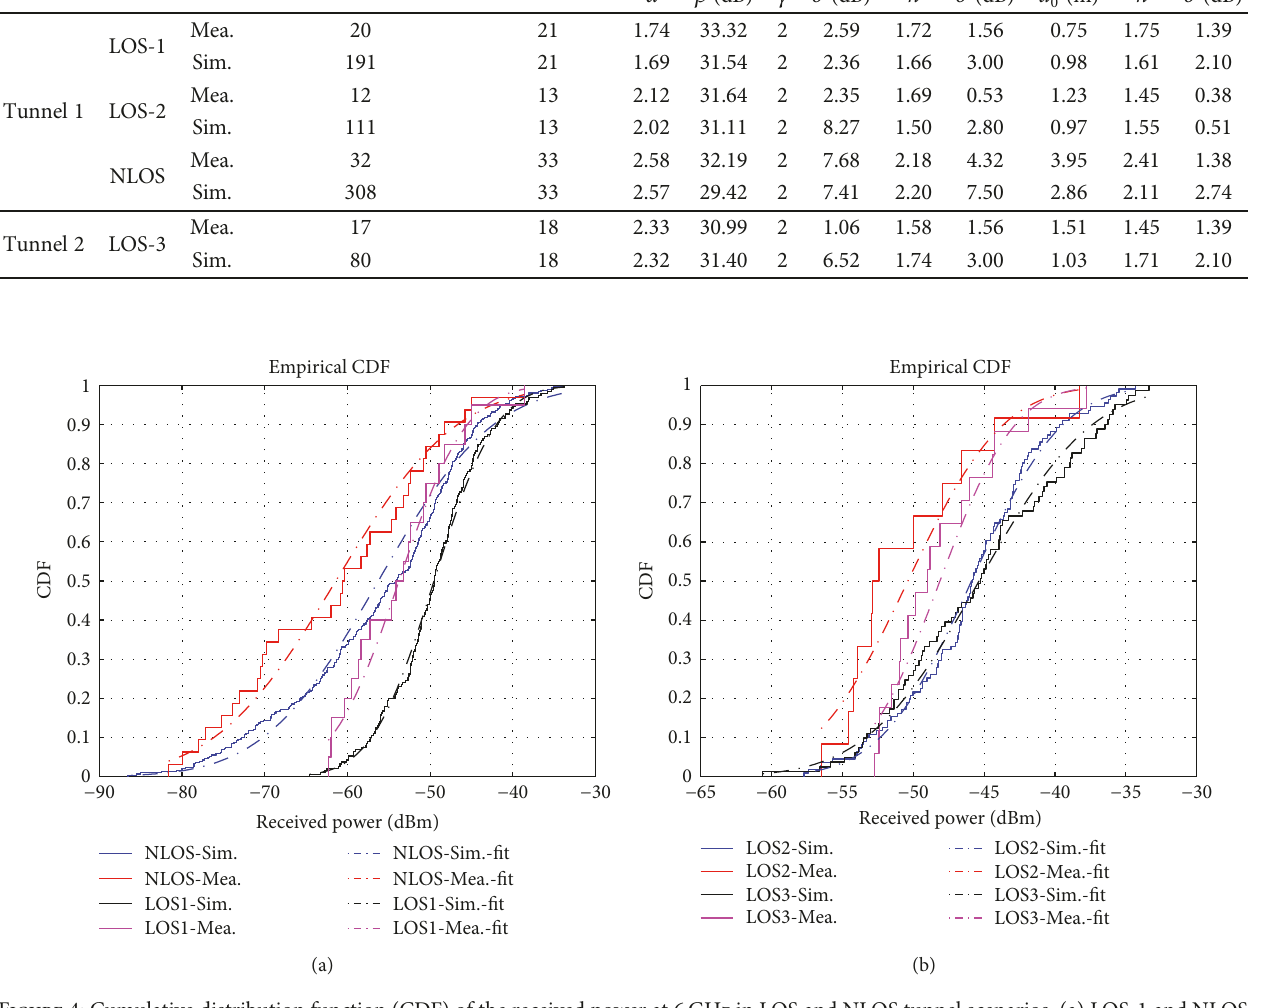
Table 2: Parameters in the ABG, CI, and CI-opt path loss models in tunnel scenarios in terms of LOS and NLOS paths at 6 GHz. Dis. Ran. denotes distance range. Number of data points denotes the number of data points. Sce.